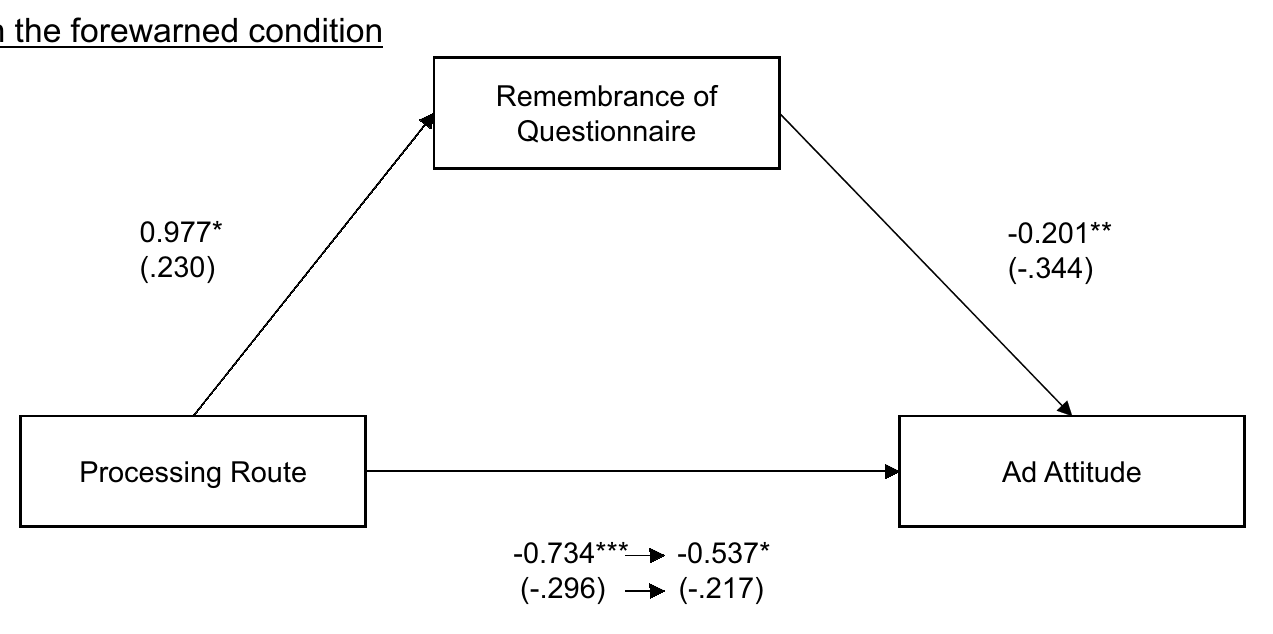
Fig 2. Mediation analysis: Ad attitude mediated by remembrance of